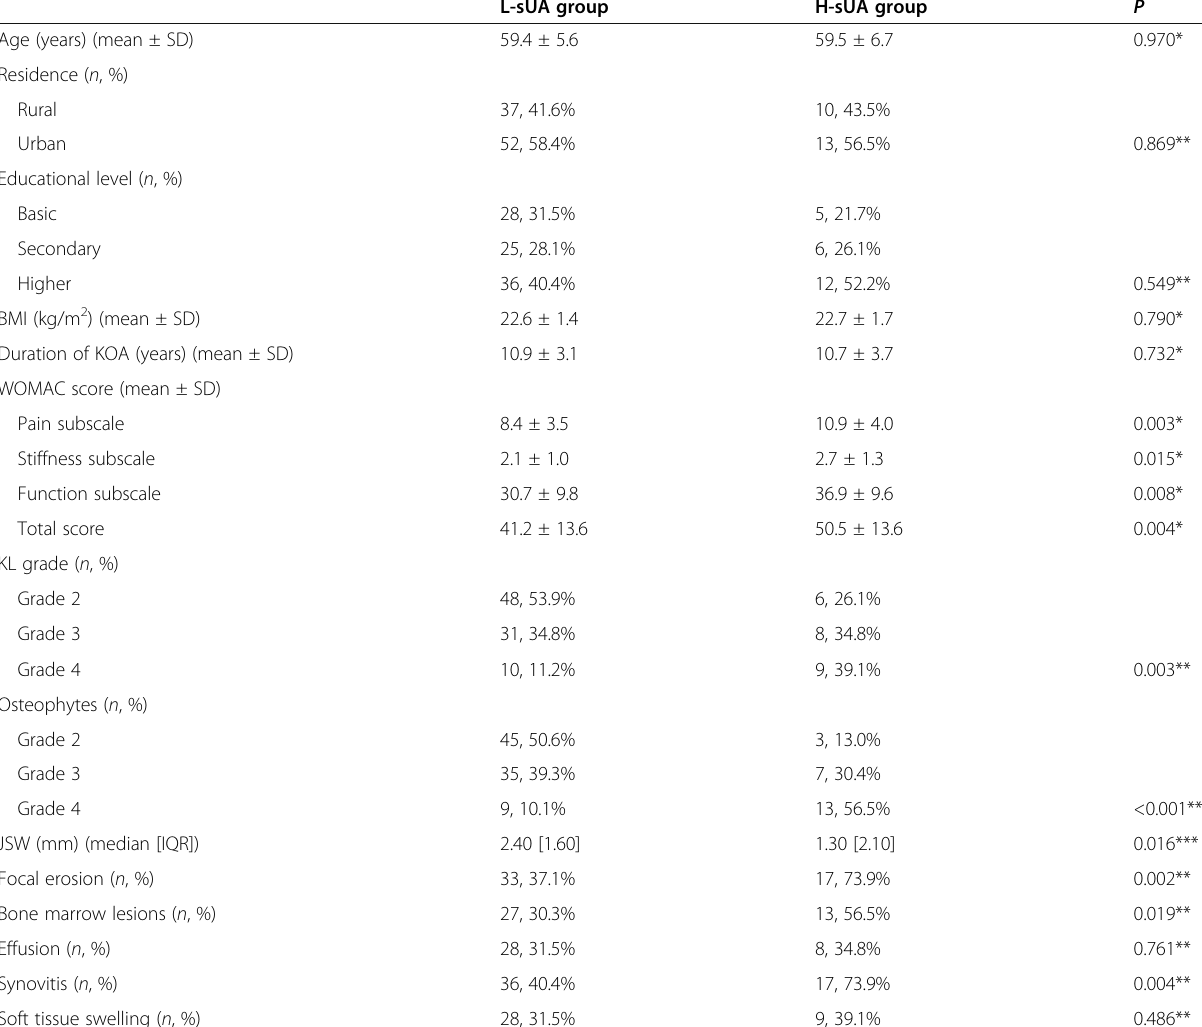
Table 2 Comparison of socio-demographic characteristics, clinical findings, and radiological findings between female knee osteoarthritis patients in low serum uric acid group versus high serum uric acid